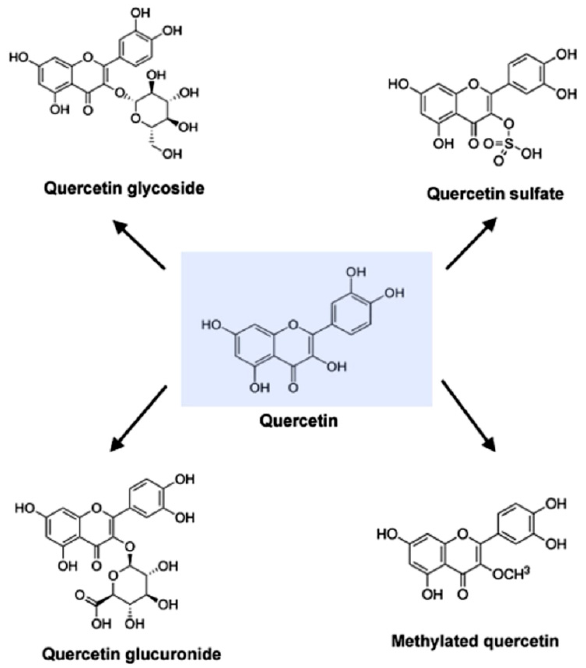
Figure 1. Molecular structure of quercetin, quercetin glycoside, quercetin glucuronide, quercetin sulfate and methylated quercetin.